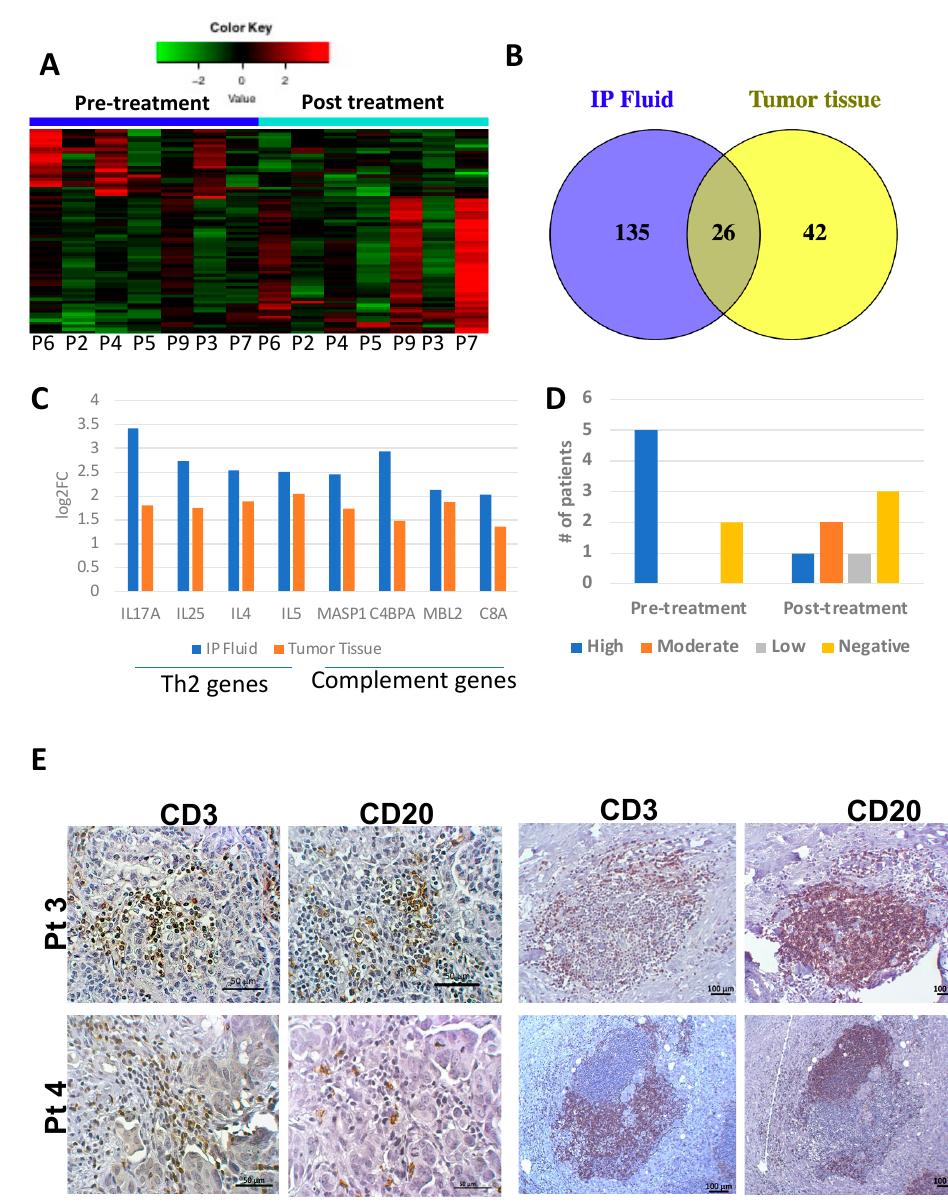
Figure 3. Immune gene changes between pre-treatment and post-treatment tumor tissues. ( A ) Heat map for 68 DE genes ( p < 0.05) showing overall upregulation. ( B ) Venn diagram demonstrating that 26 genes are DE from beginning to end of chemotherapy treatment in both tumor tissue and IP fluid.